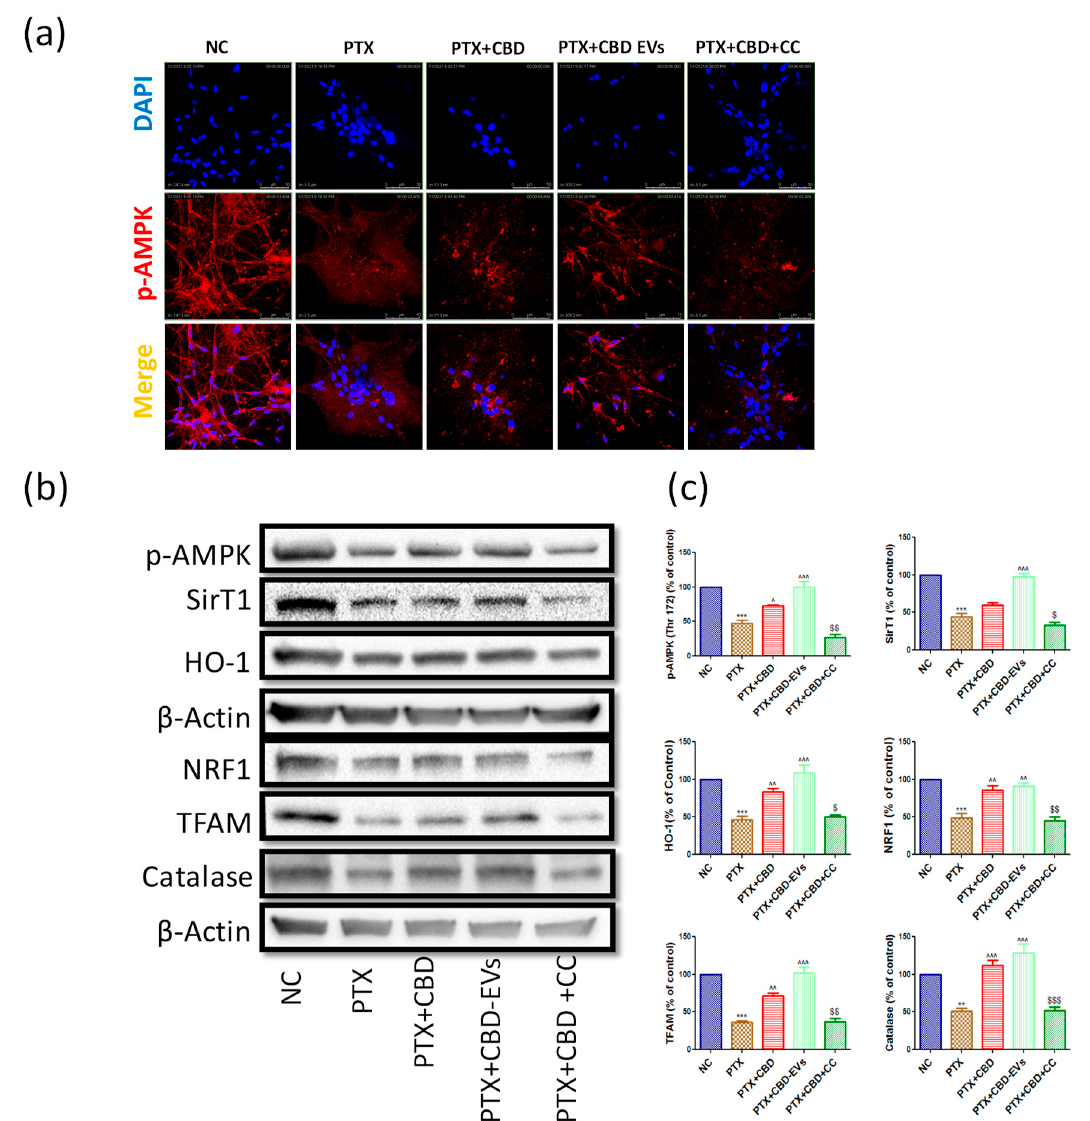
Figure 8. Immunoexpressions of the AMPK pathway in cultured DRG primary cells ( a ) Representative confocal microscope images showing the upper panel nuclear (DAPI) staining, middle panel: immuno expression of p-AMPK (Thr 172) labeled with rhodamine, and lower panel showing the merge of p-AMPK and DAPI ( b ) Western blots of cultured DRG lysates show treatment with 12 µM either of CBD and CBD-EVs in PTX-treated neuronal cells for 48 h ( c ) Bar graphs represent the respective western blots quantification. ** p < 0.01 and *** p < 0.001 vs. NC, ^ p < 0.05, ^^ p < 0.01 and ^^^ p < 0.001 vs. PTX (8 mg/kg). $ p < 0.05, $$ p < 0.01 and $$$ p < 0.001 vs. PTX + CBD. NC: Untreated adult rat DRG primary cells, PTX: The primary cells (DRG cultures) were grown and treated with 3 µM paclitaxel for 48 h, PTX + CBD: The primary cells (DRG cultures) were grown and treated with 3 µM paclitaxel followed by post-treatment with 12 µM of CBD for 48 h, PTX + CBD-EVs: The primary cells (DRG cultures) were grown and treated with 3 µM paclitaxel followed by post-treatment with 12 µM of CBD-EVs for 48 h, PTX + CBD + CC: The primary cells (DRG cultures) were grown and treated with 3 µM paclitaxel followed by post-treatment with 12 µM of CBD and 10 µM of compound C for 48 h.